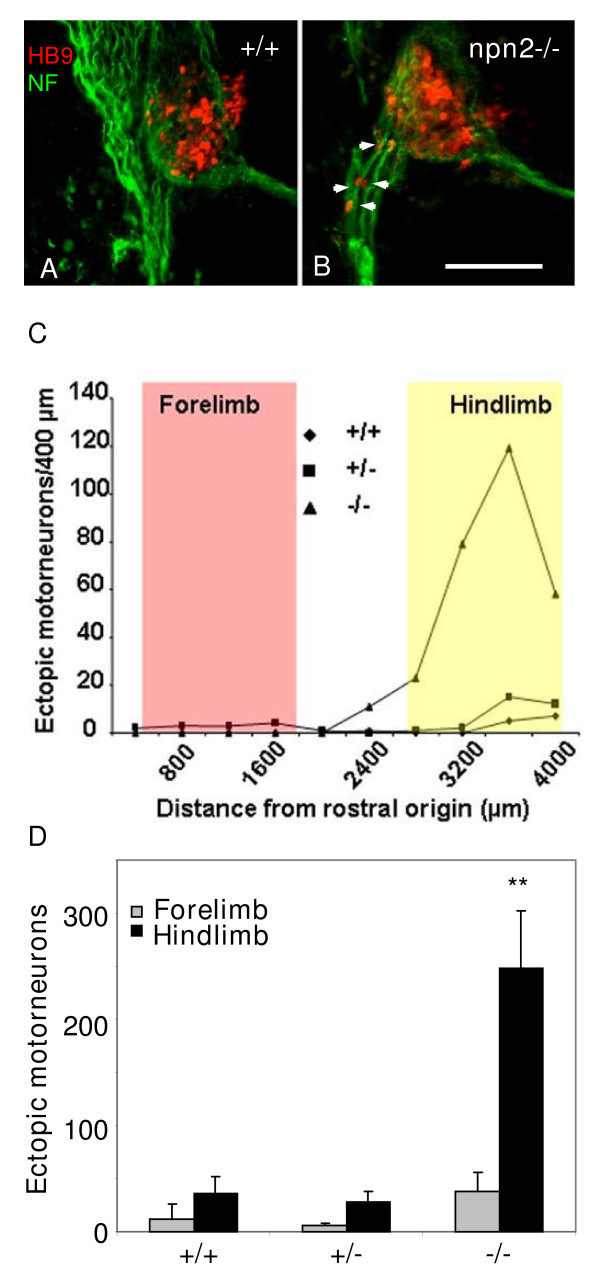
Motor neurons migrate to ectopic positions in Npn-2 null mice. (a,b) Dual immunostaining of transverse cryosections (20 μm) of E11.5 wild-type (a) or Npn-2 null (b) littermate mouse embryo spinal cord with antibodies against HB9 (red) or neurofilament (NF; green) reveal numerous HB9-positive ectopic motor neurons located in the marginal zone and ventral nerve root in mutant but not wild-type embryo sections ((b) white arrows). Bar = 150 μm. (c) A quantitative analysis of the distribution of HB9-positive ectopic motor neurons along the rostro-caudal axis of Npn-2 null (triangles) or heterozygous (squares) and wild-type (diamonds) littermate embryos indicates that the number of ectopic motor neurons is normal at forelimb level (red box) but peaks at hind limb level (yellow box). (d) A comparison of pooled and averaged number of HB9-positive ectopic motor neurons in the anterior (forelimb containing half) and the posterior (hindlimb containing half) of the trunk, for E12.5 Npn-2 wild-type, heterozygous and null littermate embryos (n = 4). Consistent with the quantitative analysis shown in (c), there is a significant increase in ectopic motor neurons in the hindlimb region of Npn-2 null mice. **P ≤ 0.01; two-tailed t-test.